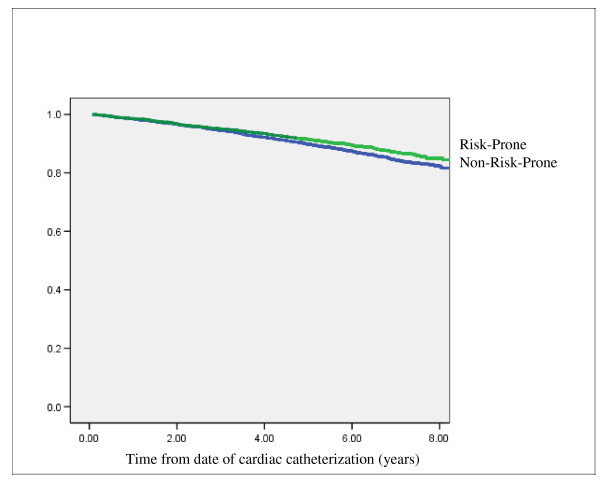
Kaplan-Meier Plot for Survival Based on Risk Attitudes (risk-prone versus non-risk-prone).